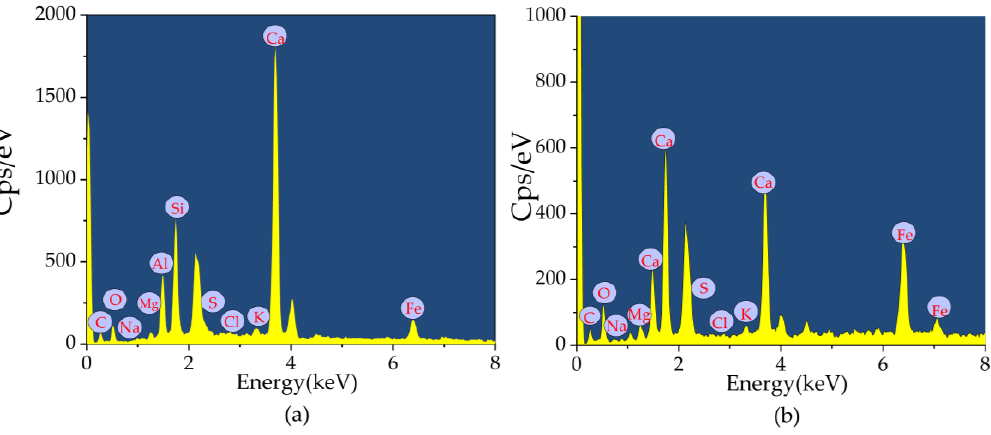
Figure 11. EDS patterns of Figure 9a,b: ( a ) Aft; ( b ) C - S -